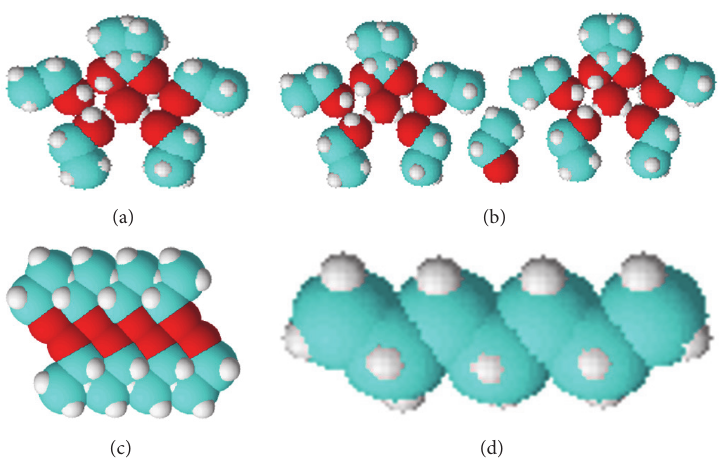
Figure 9: The molecular structure of (a) azeotropic ethanol; (b) ethanol of 95.5% v; (c) anhydrous ethanol; (d) n-heptane.